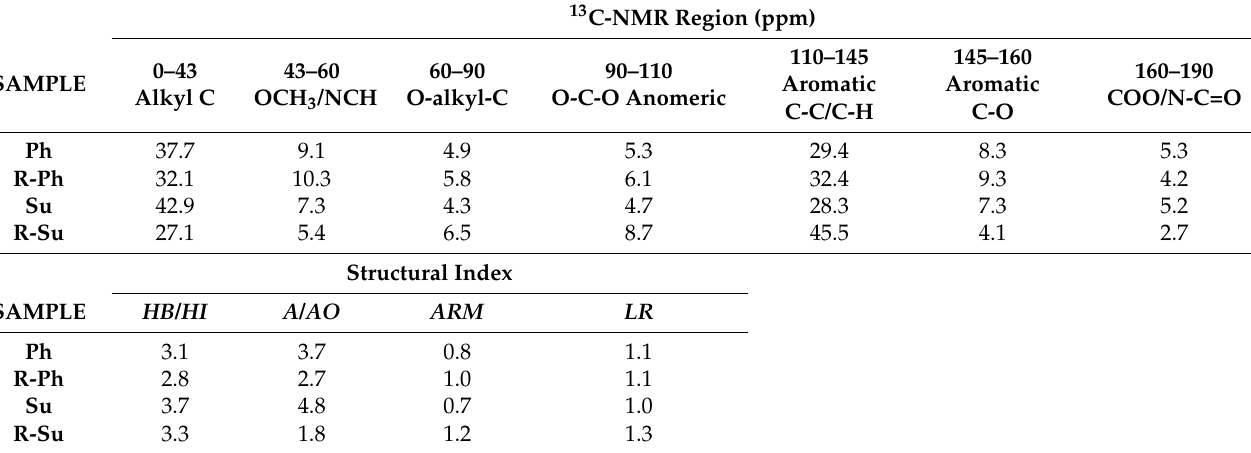
Table 1. Relative organic carbon (OC) distribution (%) over chemical shift regions (ppm) in 13C-CPMAS-NMR spectra of hydrochar samples and related structural